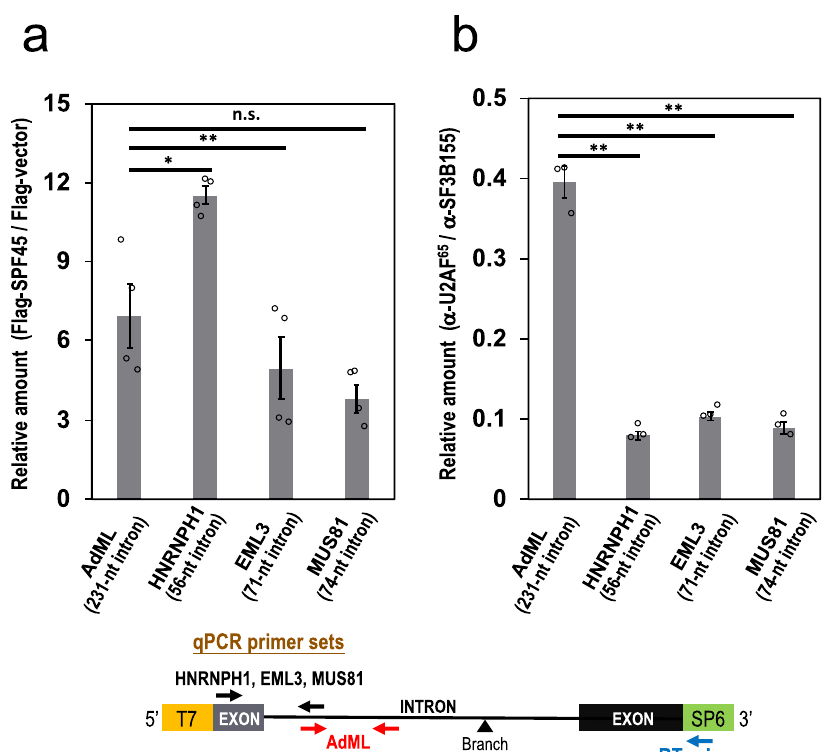
Fig. 4 SPF45 binds to all introns while U2AF 65 cannot bind to short introns. a Cellular formaldehyde crosslinking and immunoprecipitation experiments shows SPF45 binding to all the indicated introns. Mini genes containing these four introns were individually co-transfected into HEK293 cells with a plasmid expressing Flag-SPF45 protein. The Flag-SPF45 was immunoprecipitated after formaldehyde crosslinking and then co-precipitated pre-mRNAs were quanti fi ed by RT – qPCR using speci fi c primers (see the schematic mini gene below). Means ± SEM are given for three independent experiments and two-tailed Student t -test values were calculated ( p = 0.0353 for AdML vs HNRNPH1 intron, p = 0.0083 for AdML vs EML3 intron, p = 0.0638 for AdML vs MUS81 intron). * P < 0.05, *** P < 0.0005, n.s. P > 0.05. b Cellular CLIP experiments shows strong U2AF 65 binding to control AdML pre-mRNA but not much to the three indicated short introns. Mini genes containing these four introns were individually co-transfected into HEK293 cells and irradiated with UV light. The lysates were immunoprecipitated with anti-U2AF 65 and anti-SF3b155 antibodies and then immunoprecipitated RNAs were quanti fi ed by RT – qPCR using speci fi c primers (see the schematic mini gene below). Means ± SEM are given for three independent experiments and two-tailed Student t -test values were calculated ( p = 0.0034 for AdML vs HNRNPH1 intron, p = 0.0066 for AdML vs EML3 intron, p = 0.0020 for AdML vs MUS81